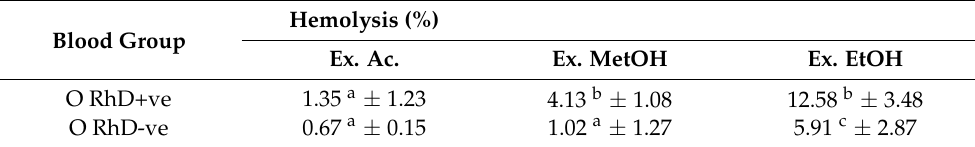
Table 4. Effect of the direct hemolysis from N. incerta extracts on erythrocytes O RhD+ve and RhD-ve. Blood Group